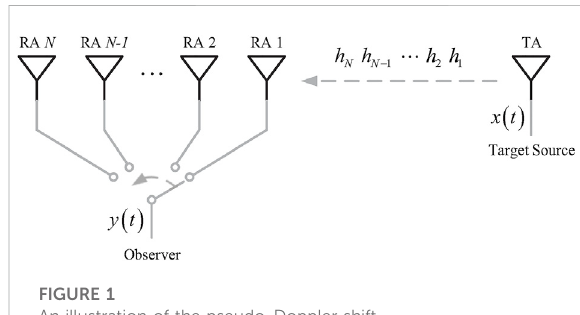
FIGURE 1 An illustration of the pseudo-Doppler